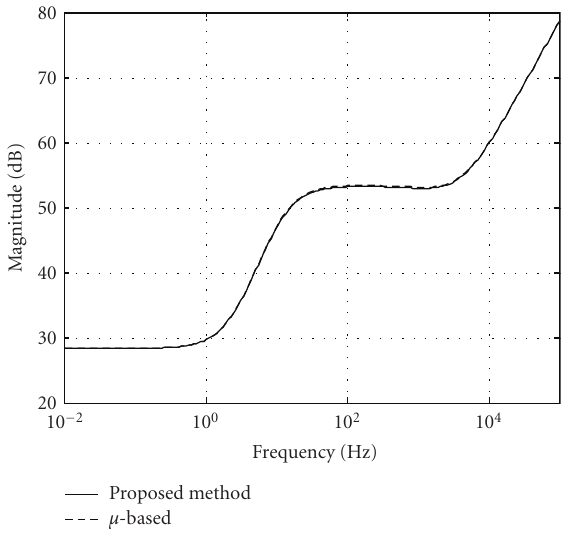
Figure 8: The necessary and su ffi cient robust performance bounds for controller uncertainty derived by the proposed method and using μ -based calculation.